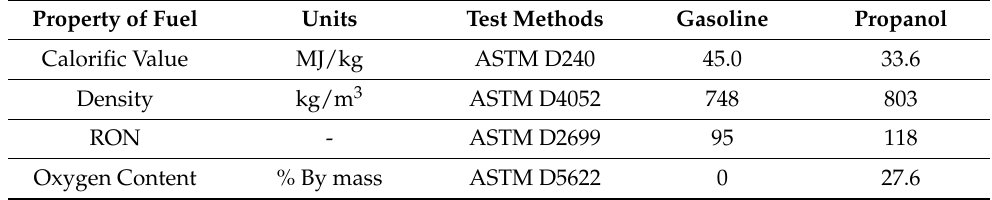
Table 2. Properties of fuel adopted for the